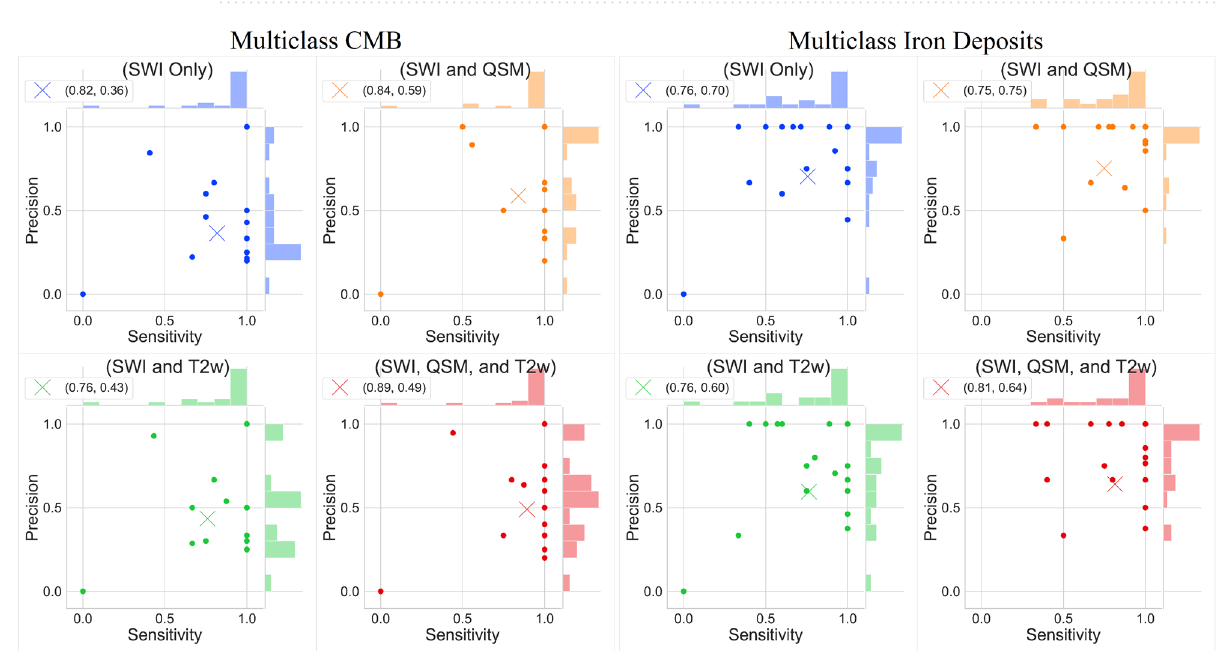
Figure 3. Joint scatterplots of the sensitivity vs precision of all multiclass experiments predicting CMBs and non-hemorrhage iron deposits. (Left) all evaluations for CMBs and (Right) all evaluations for iron deposits. In each subplot, the round points indicate the individual participants’ sensitivity and precision evaluated with leave-one-out cross-validation, and the X indicates the mean sensitivity and precision. The legend at the upper left corner of each subplot shows the coordinates of X. In each subplot, histograms of the sensitivity and precision are displayed along the upper and right